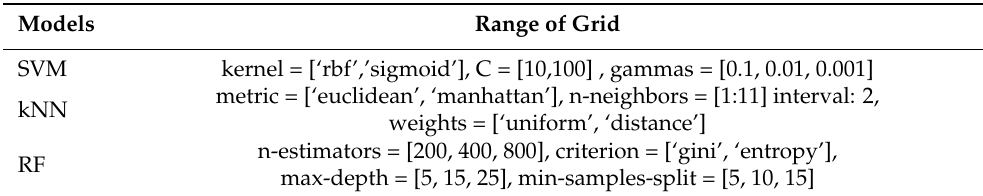
Table 3. Optimized hyperparameters for each